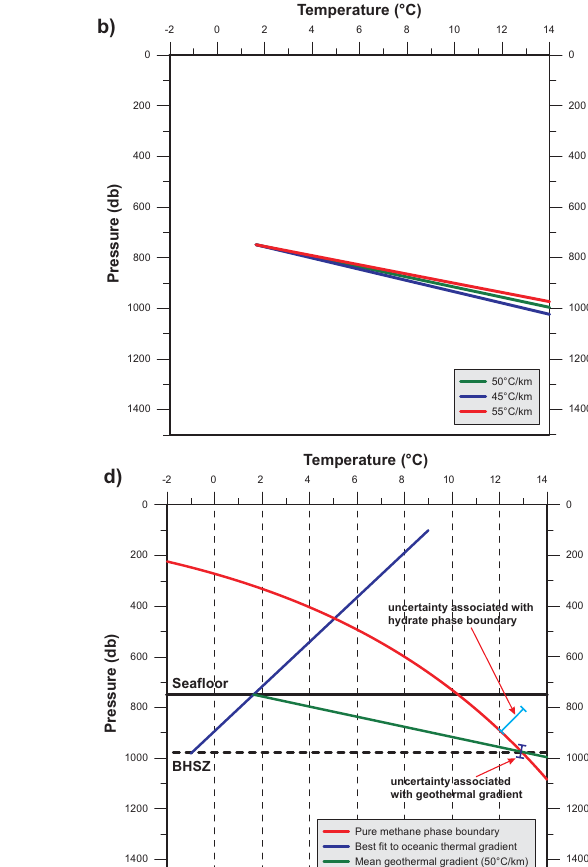
Figure 2. Input parameters used to define the thermobaric hydrate stability zone (HSZ) model. ( a ) Hydrate phase boundary; ( b ) Geothermal gradients; ( c ) Oceanic thermal gradients; ( d ) The complete system plotted on the pressure-temperature diagram. The model is kept on the same scale to allow for comparison of the effect of the various parameters. Pressure is given in decibars (db).